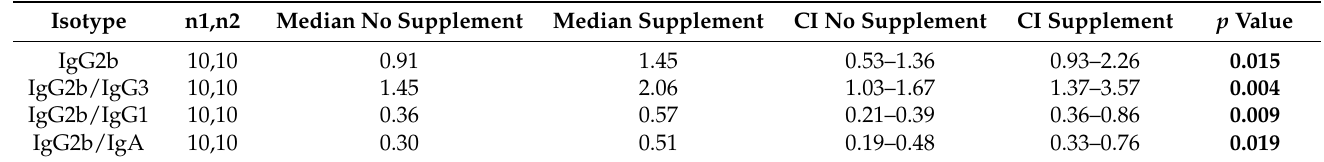
Figure 4. Testosterone supplements affect immunoglobulin isotype patterns in male mice. Each symbol represents a different mouse. Group medians are shown with 95% CI. p values from Mann–Whitney tests are shown when p ≤ 0.10. Individual isotypes ( A – E ) and ratios ( F – H ) are shown. Table 4. Higher preference for IgG2b in testosterone-supplemented compared to unsupplemented male mice.